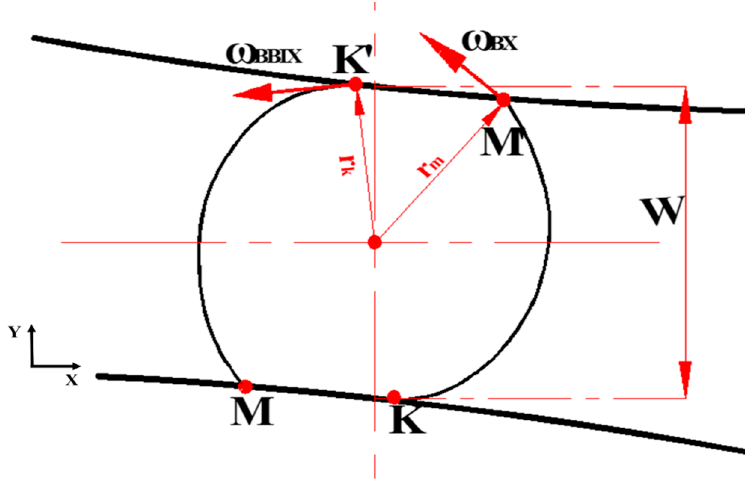
Figure 2. Schematic diagram deformation of simple shafts under load during CWR.